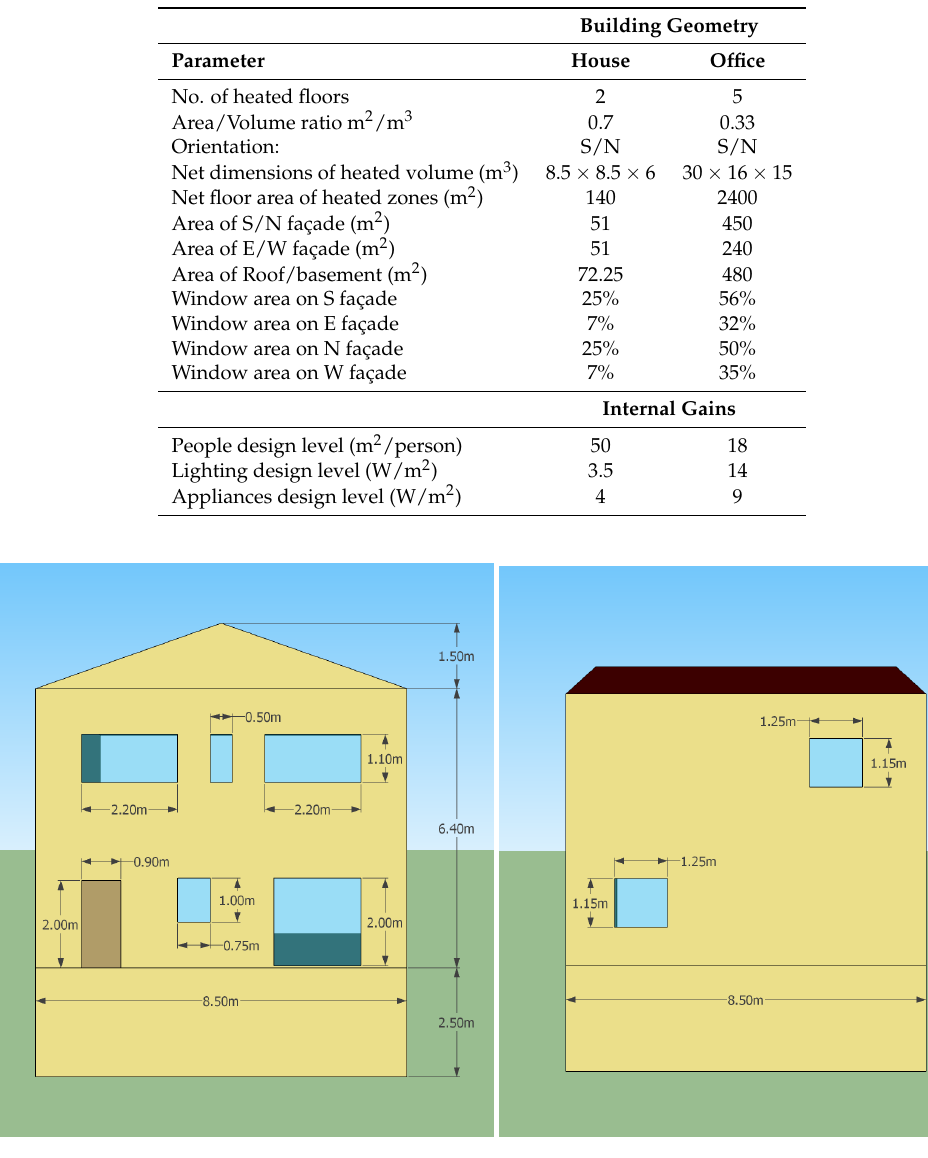
Table 1. Parameters of the two building models used for the EnergyPlus simulations.